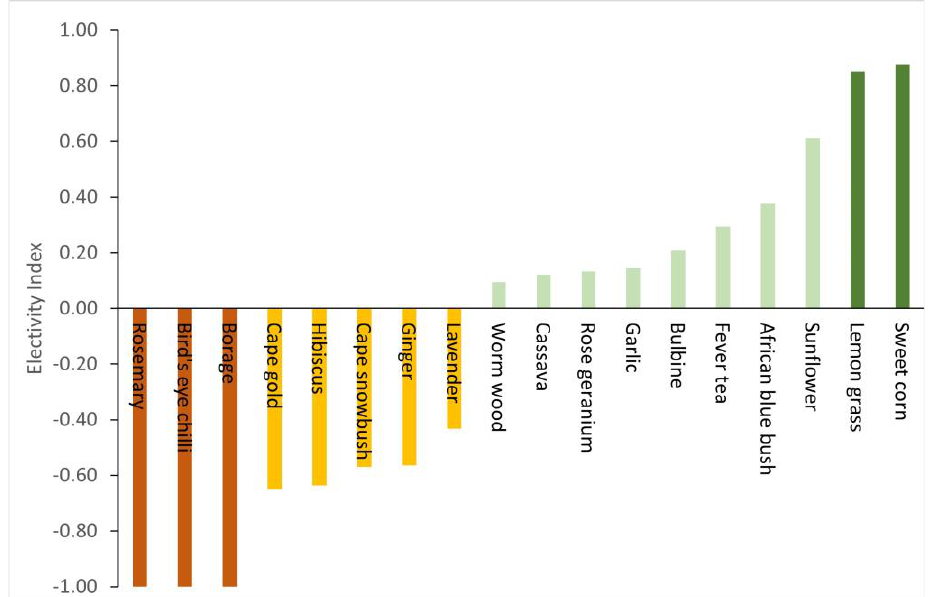
Figure 6. The Electivity Index in ascending order as calculated across all sessions for both elephants